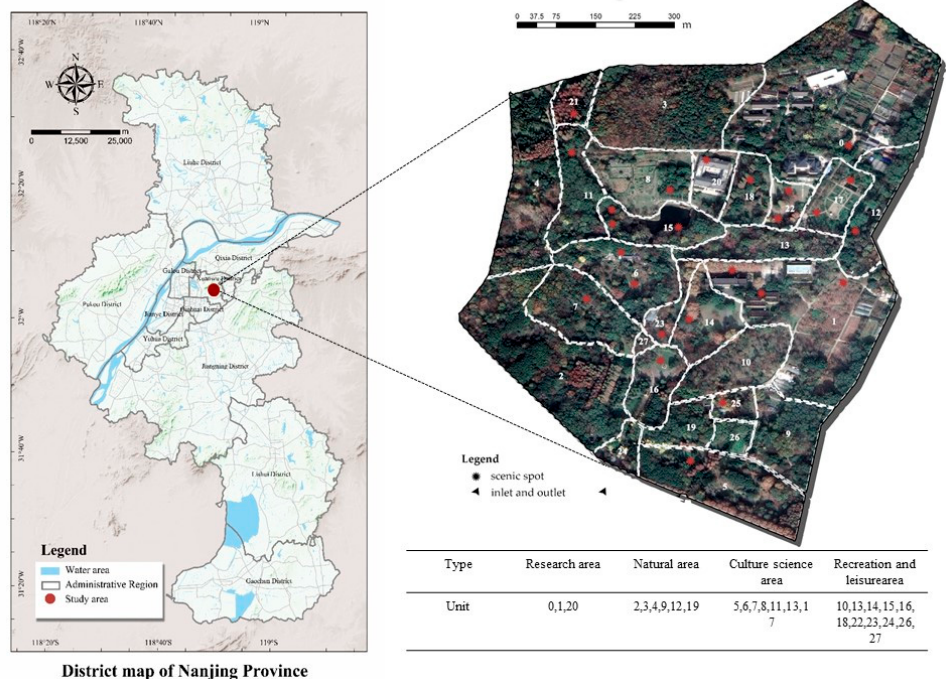
Figure 1. Location and zoning of the study area.